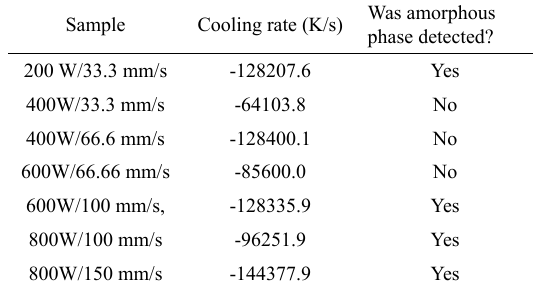
Table 1. Calculated cooling rates for the samples investigated by DSC.